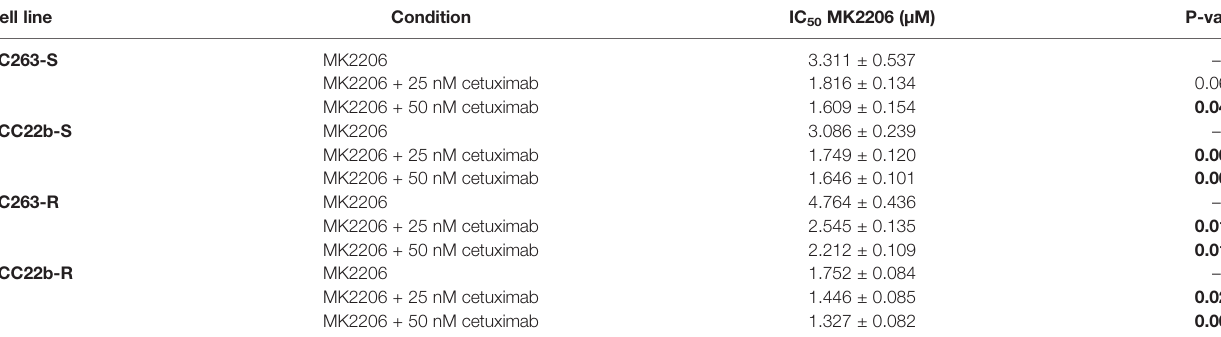
TABLE 1 | IC 50 and standard errors for HNSCC cell lines after treatment with MK2206 plus cetuximab for 72h. Cell line